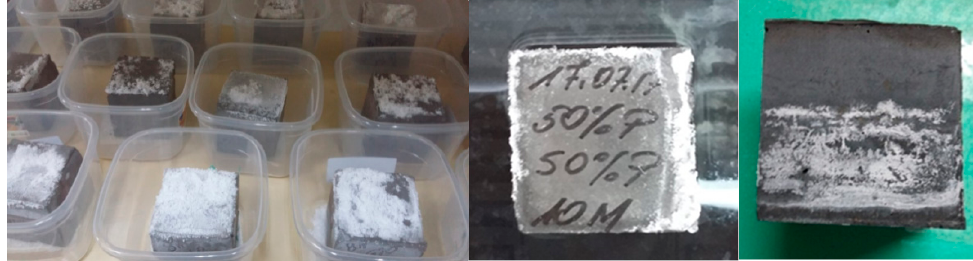
Figure 7. Appearance of selected samples during tests for susceptibility to e ffl orescence (after 14 days); samples cured at ambient conditions.